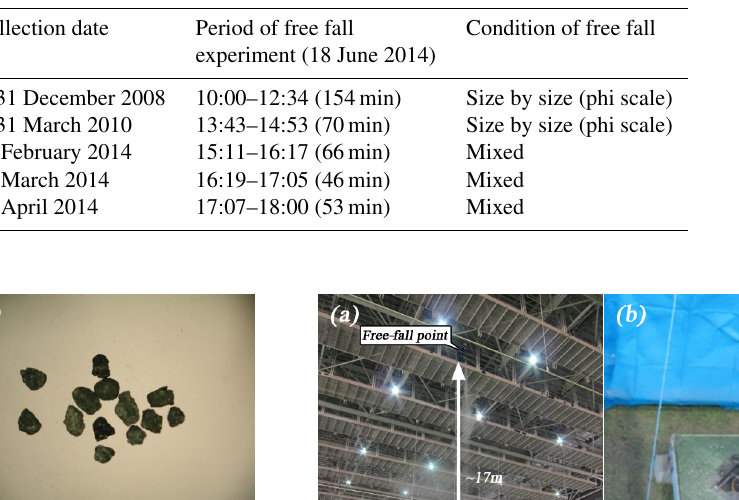
Table 2. Information on the collected volcanic ash particles.